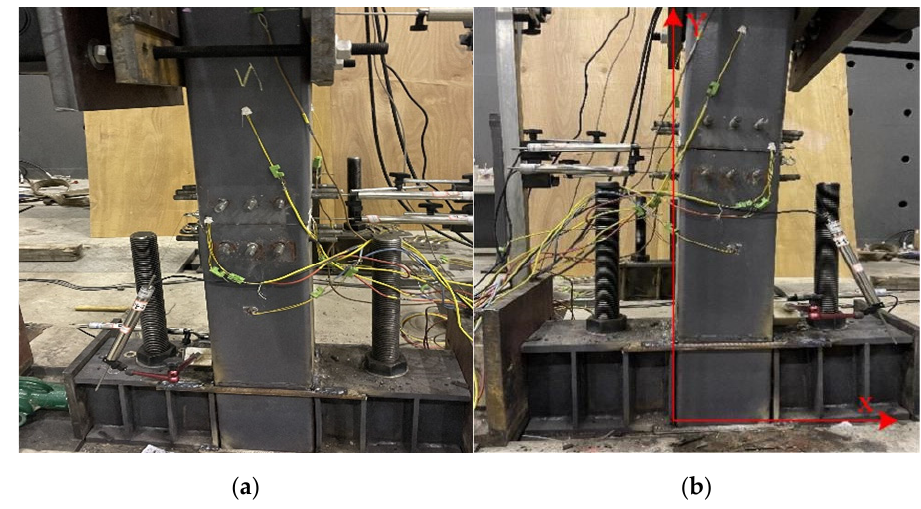
Figure 10. CFST-0 loading diagram, ( a ) Before loading, ( b ) After loading.